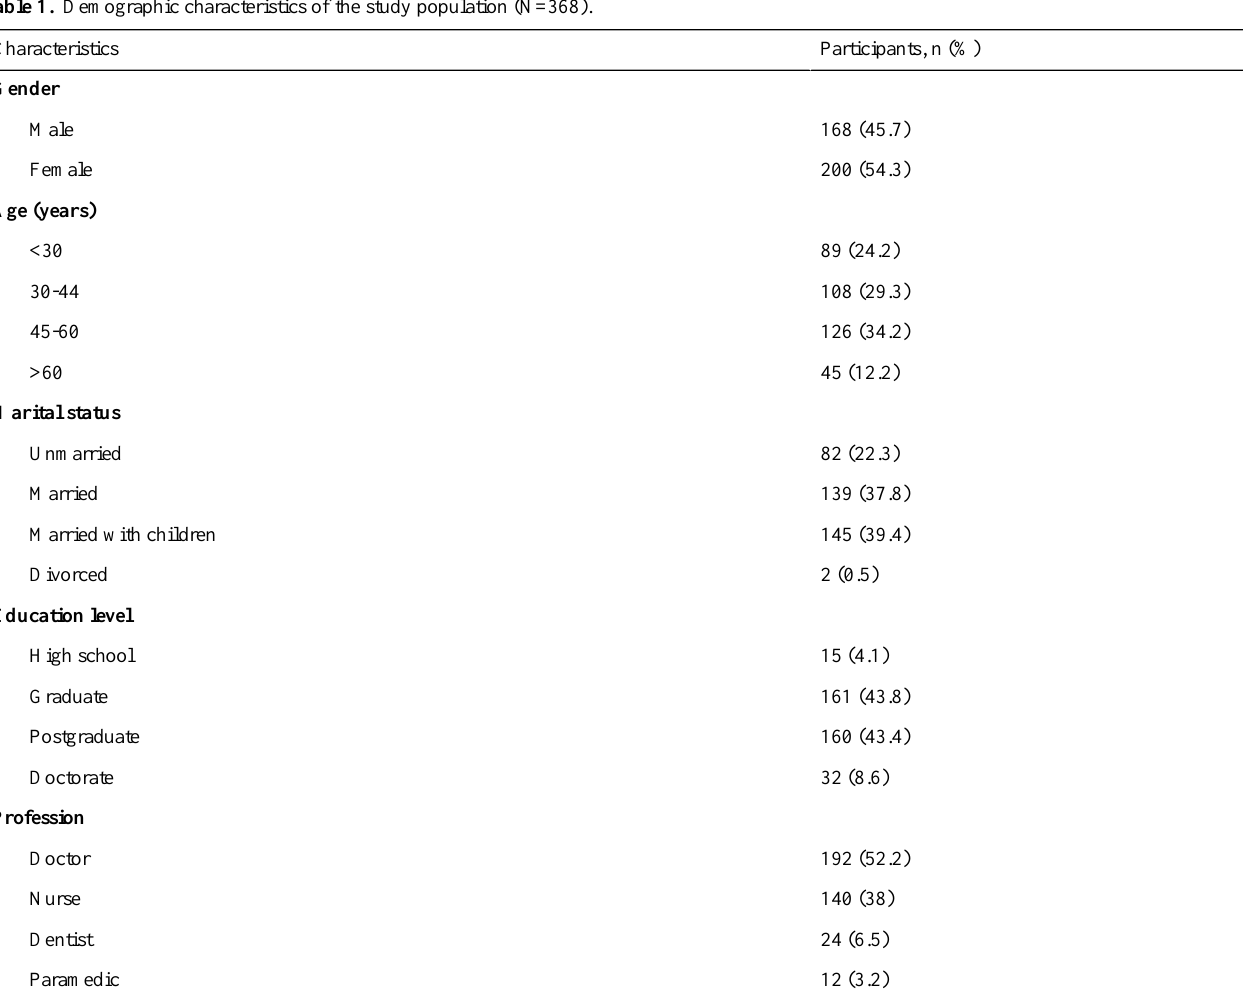
Table 1. Demographic characteristics of the study population